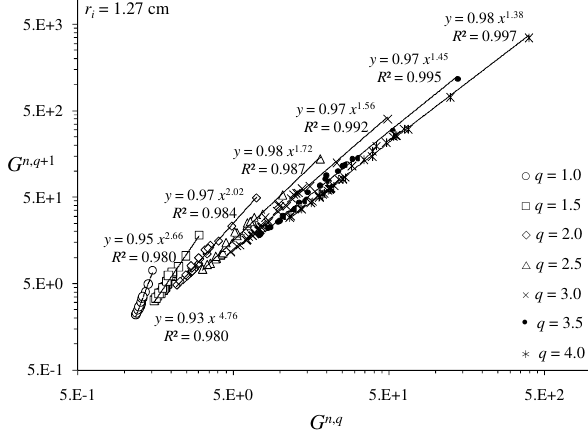
Fig. 7. G n,q + 1 versus G n,q for n =0.5, 1.0 ≤ q ≤ 4.0, r i =1.27cm evaluated on face 1 along x-axis. Linear regression equations and relative regression coefficients ( R 2 ) are also reported.